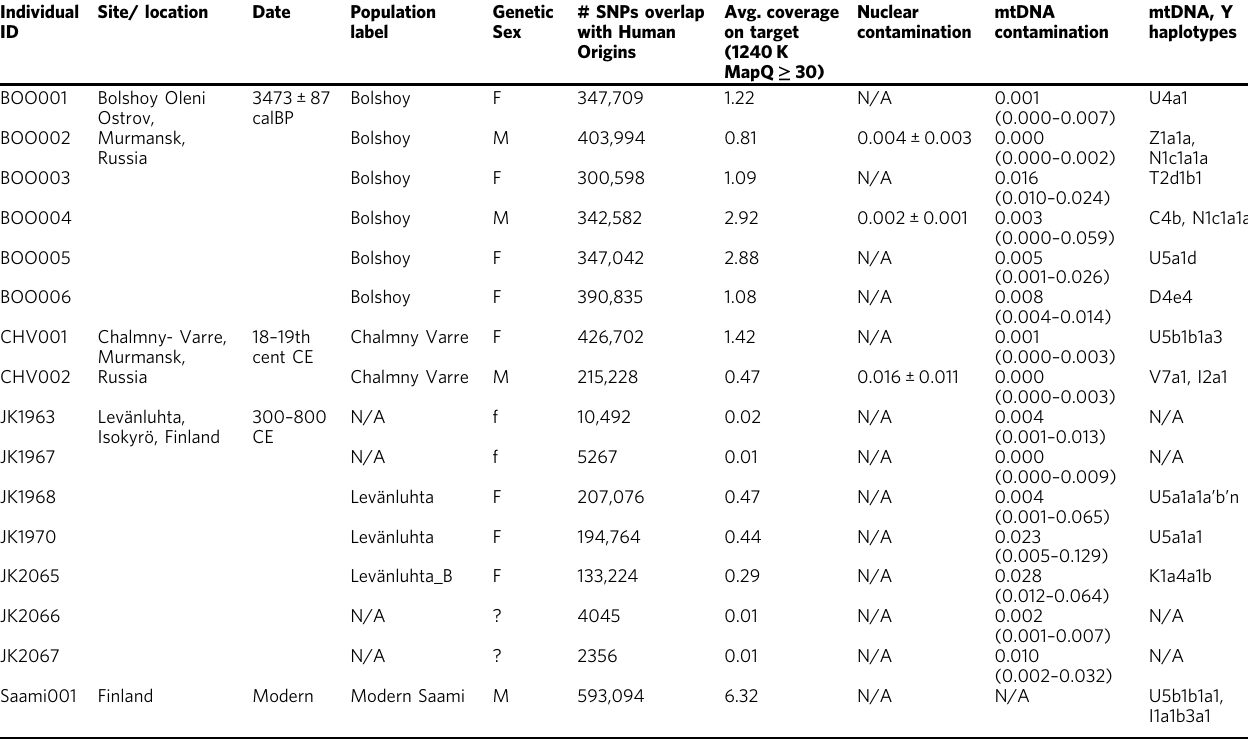
Summaryinformationforallindividualsforwhichwereportgenomicdatainthisstudy.AradiocarbondateisgivenfortheBolshoysamples,asdescribedinSupplementaryText1.Otherdatesarecontext- based, as described in Supplementary Text 1. Population labels for individuals of low coverage are shown as N/A. Genetic sex is determined as described in Methods, and lowercase letters denote probable genetic sex for low-coverage individuals. Question marks denote unde fi ned genetic sex due to low coverage. Mitochondrial contamination estimates are given as posterior mode and 95% posterior intervals in brackets, as provided by ContamMix